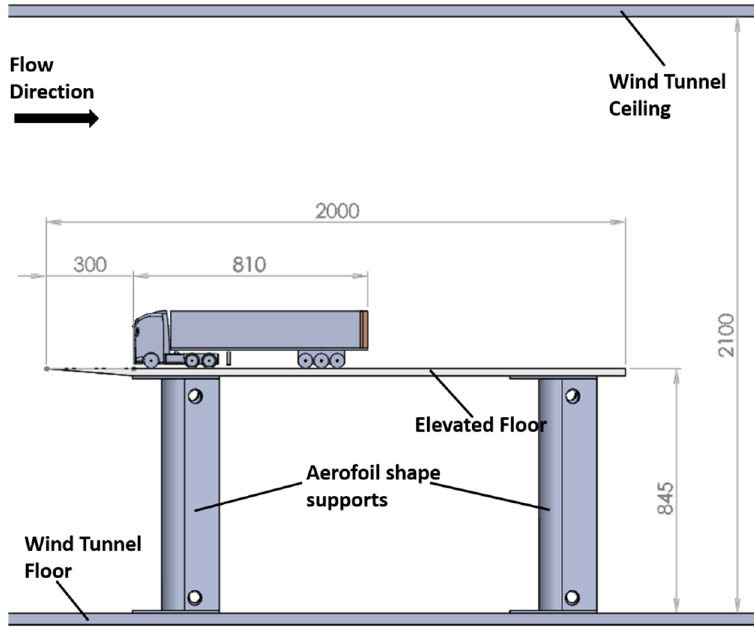
Figure 5. Schematic setup of the wind tunnel tests (adopted and modified from [11]). Note: all units are in mm.